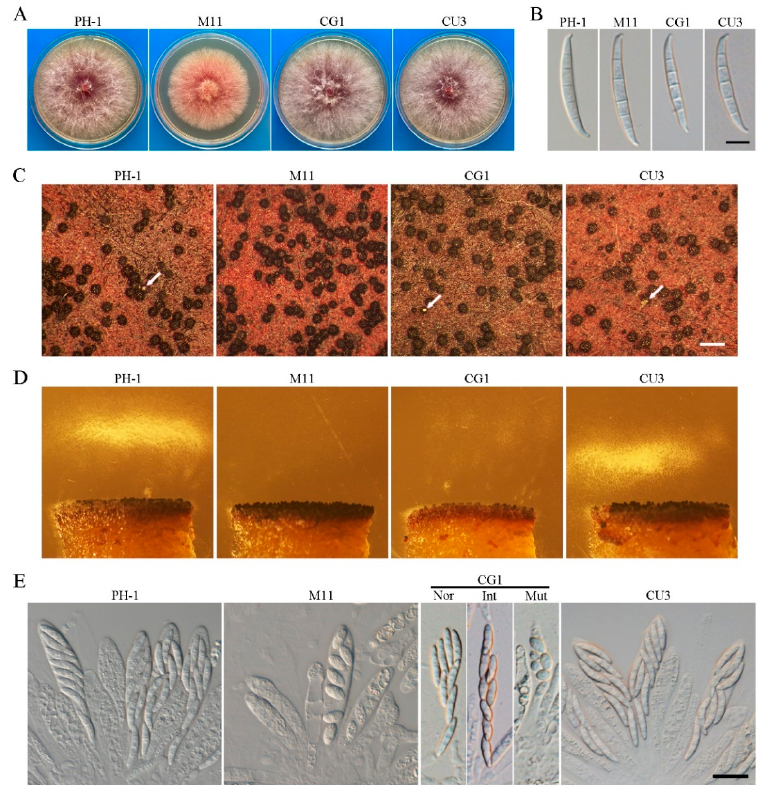
Figure 4. The expression of FgCSN12 -GFP failed to rescue the defects of the Fgcsn12 mutant in as- cosporogenesis. ( A ) Three-day-old PDA cultures of the wild type (PH-1), Fgcsn12 mutant (M11), Fgcsn12 / FgCSN12 -GFP transformant (CG1), and Fgcsn12 / FgCSN12 UTR transformant (CU3). ( B ) Co- nidial morphology of the same set of strains. Bar = 10 μ m. ( C ) Mating cultures of the same set of strains were examined at 8 dpf. Arrows point to cirrhi. Bar = 1 mm. ( D ) Ascospore discharge was assayed with 7 dpf perithecia of the same set of strains. ( E ) The same set of strains was examined for asci and ascospores in 8 dpf perithecia. Nor, Int, and Mut represent normal, intermediate, and mutant ascospores from transformant CG1, respectively. Bar = 20 μ m.